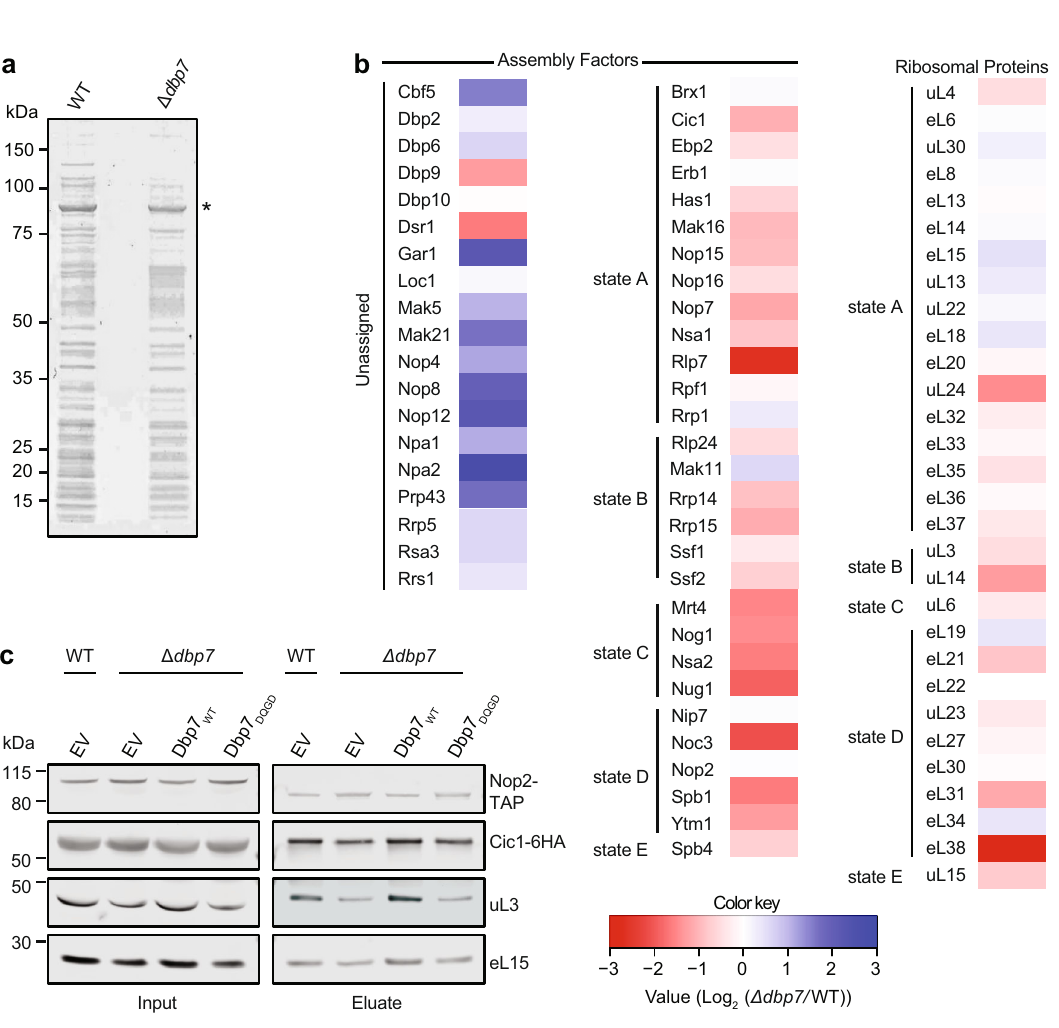
Fig. 6 Dbp7 is required for the recruitment of uL3 to pre-ribosomes. a , b Nop2-TAP particles were isolated from whole-cell lysate of wild-type (WT) and Δ dbp7 cells on IgG sepharose and eluted by overnight TEV cleavage. Associated proteins were separated by denaturing PAGE ( a ; asterisk indicates the Nop2 bait protein) and subjected to MS analysis ( b ). A heat map was generated from two independent biological replicates and shows the relative enrichment (log2 fold-change Δ dbp7 vs. WT) of assembly factors and ribosomal proteins clustered based on their available cryo-EM data (PDB: 6EM3, 6EM4, 6EM1, 6EM5, 6ELZ, 6C0F, 6CB1) 25,29 . c Pre-60S particles were isolated via Nop2-TAP from yeast strains expressing Cic1-HA from its endogenous genomic locus in the context of the Dbp7 complementation system as in ( a ). The indicated proteins were detected in input and eluate samples by western blotting using antibodies against endogenous uL3 and eL15, the HA tag for Cic1, and the calmodulin-binding protein (CBP) for